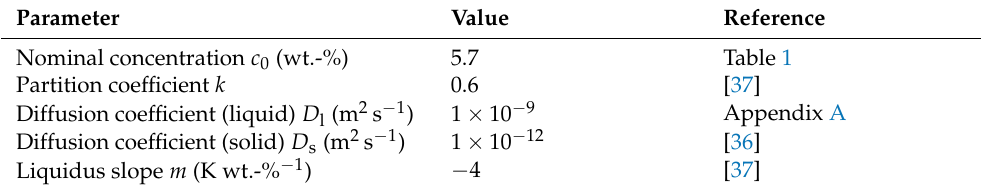
Table 5. Material parameters for a quasi binary system of Al and CMSX-4 ® .